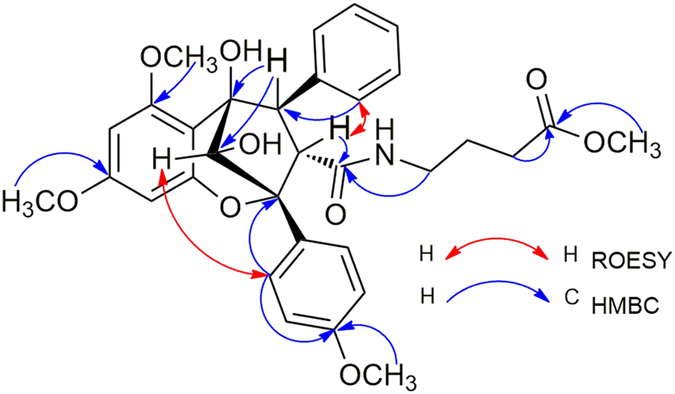
Selected key HMBC and ROESY correlations observed for 8.